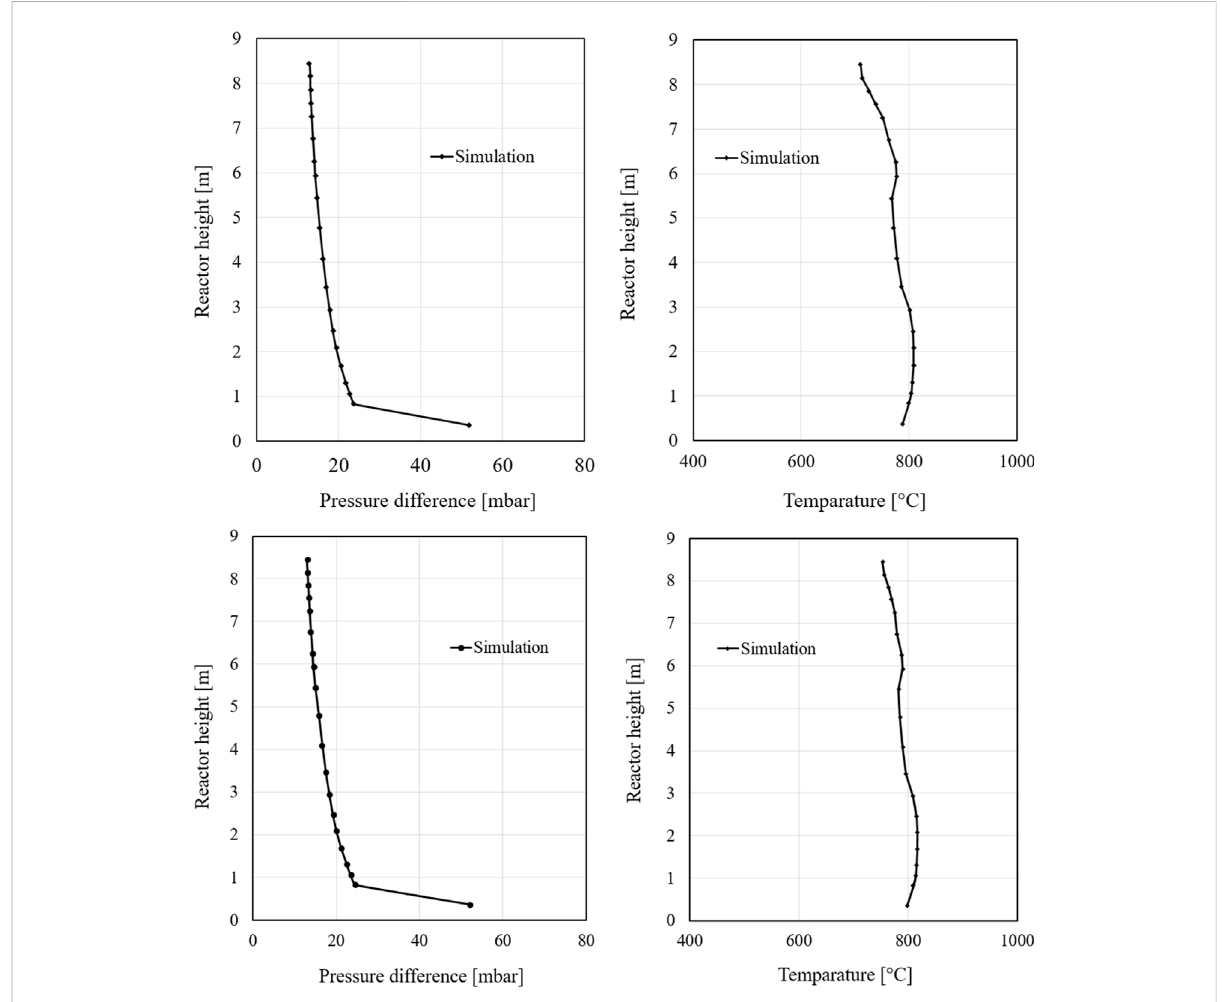
FIGURE 20 Pressure and temperature pro fi les at 30%, 50%, 80% and 99% RDF